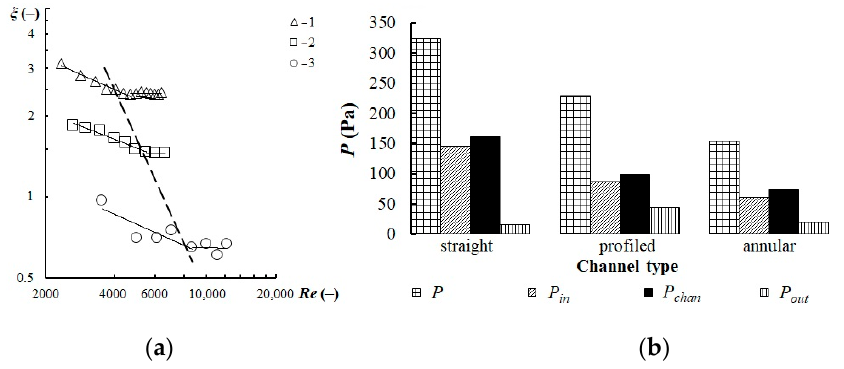
Figure 4. Dependence of the resistance coefficient value on the Reynolds number ( a ) for the con- sidered swirler types and distribution of the design pressure drop ( b ). Experimental data (1–3): 1—Swirler No. 3 (according to Table 1) at channel length l chan = 0.022 (m); 2—No. 15 at l chan = 0.025 (m); 3—No. 18 at l chan = 0.022 (m). ( b ) Calculation data at velocity in channel 𝑢 ̅ = 1 4